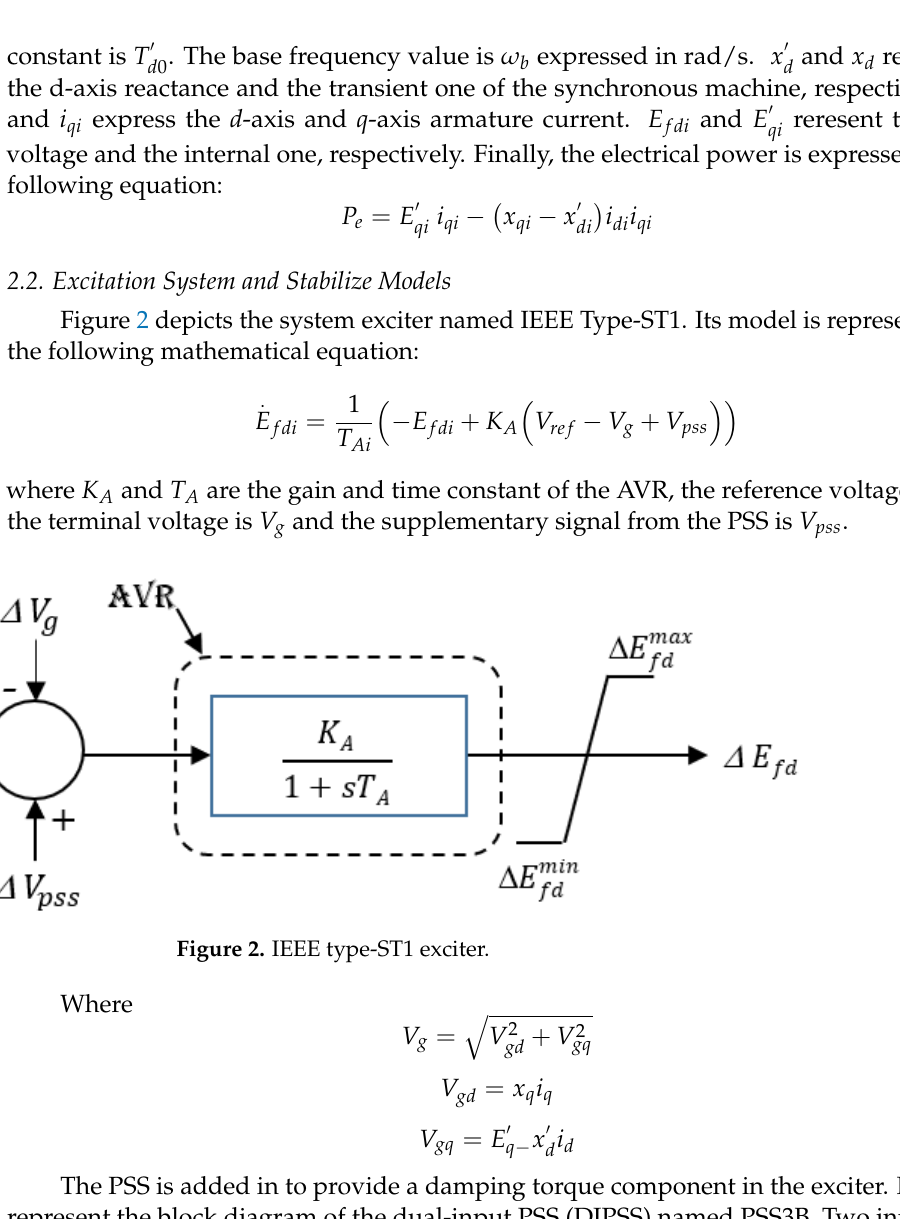
Figure 1. SMIB test system.